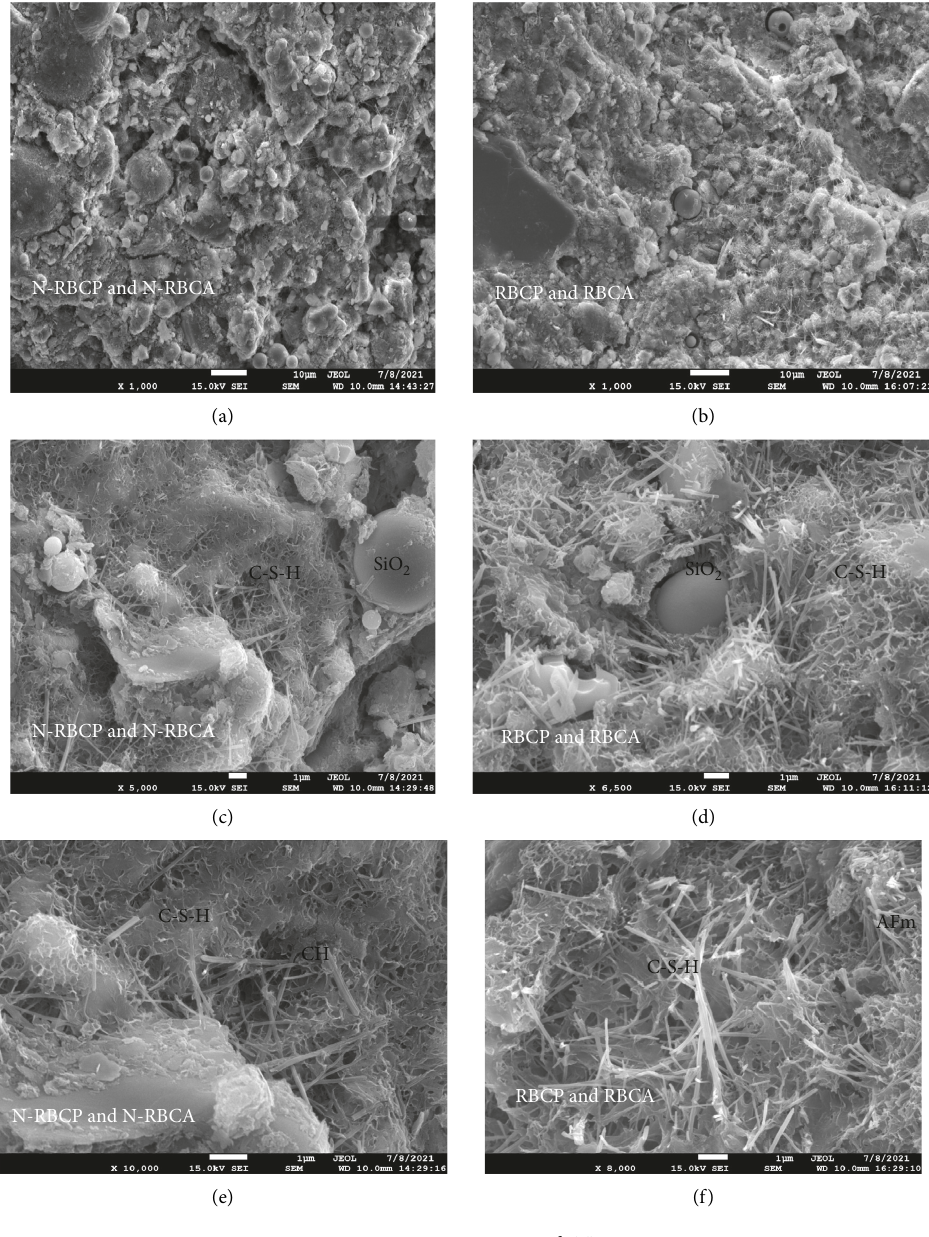
Figure 6: SEM images of